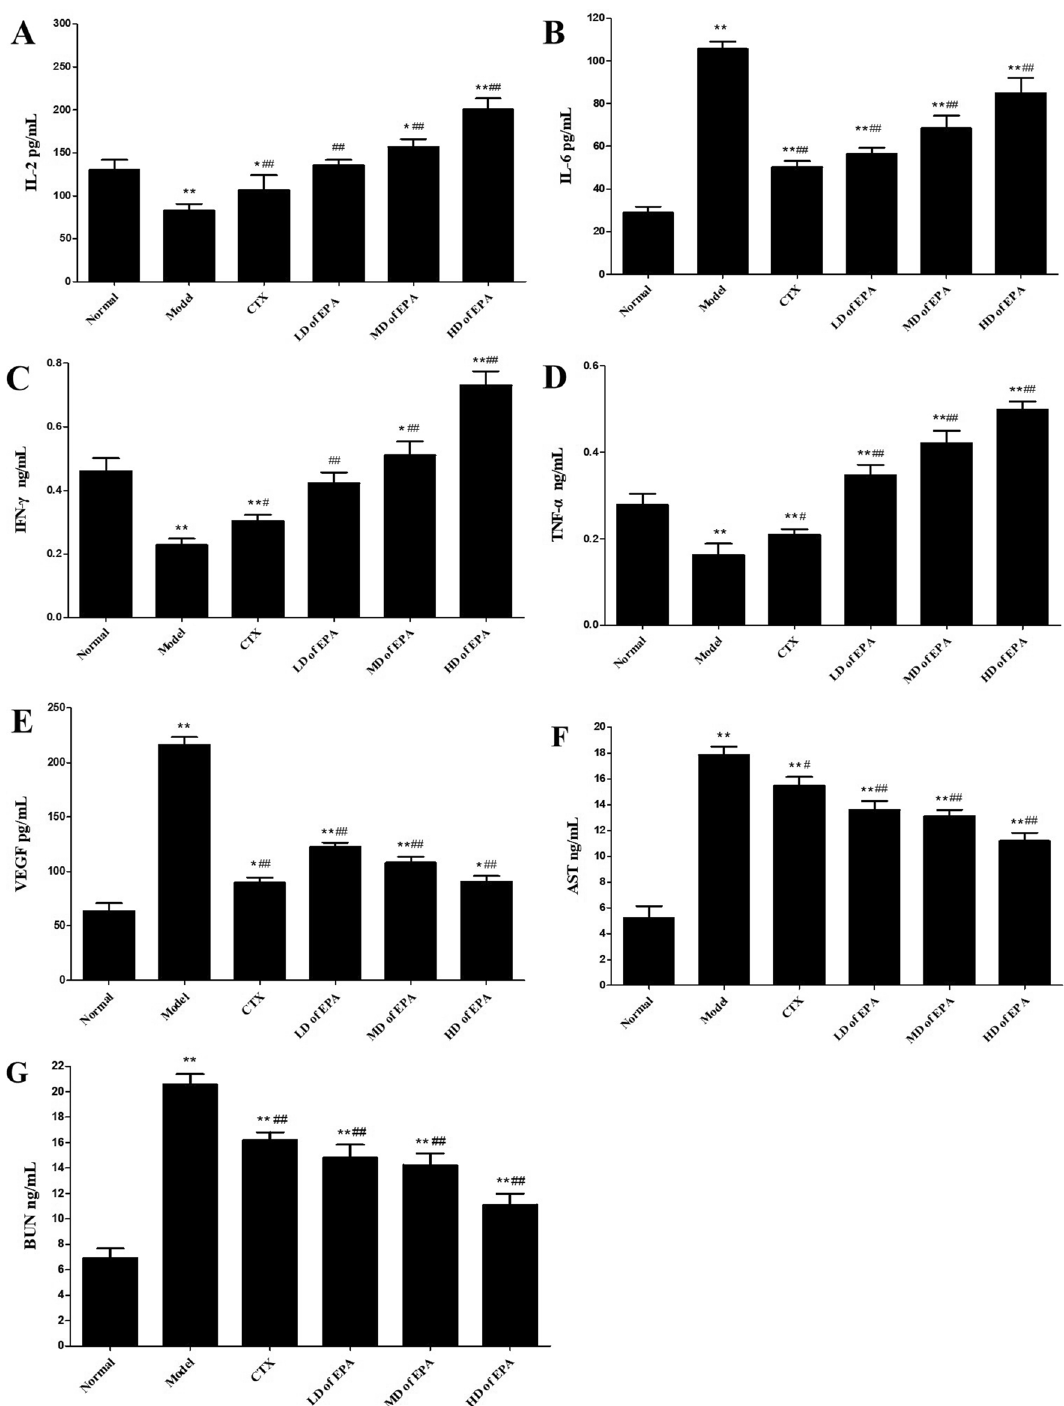
Figure 3. Effects of EPA on levels of serum cytokines, including, IL-2 ( A ), IL-6 ( B ), IFN-γ ( C ), TNF-α ( D ), VEGF ( E ), AST ( F ) and BUN ( G